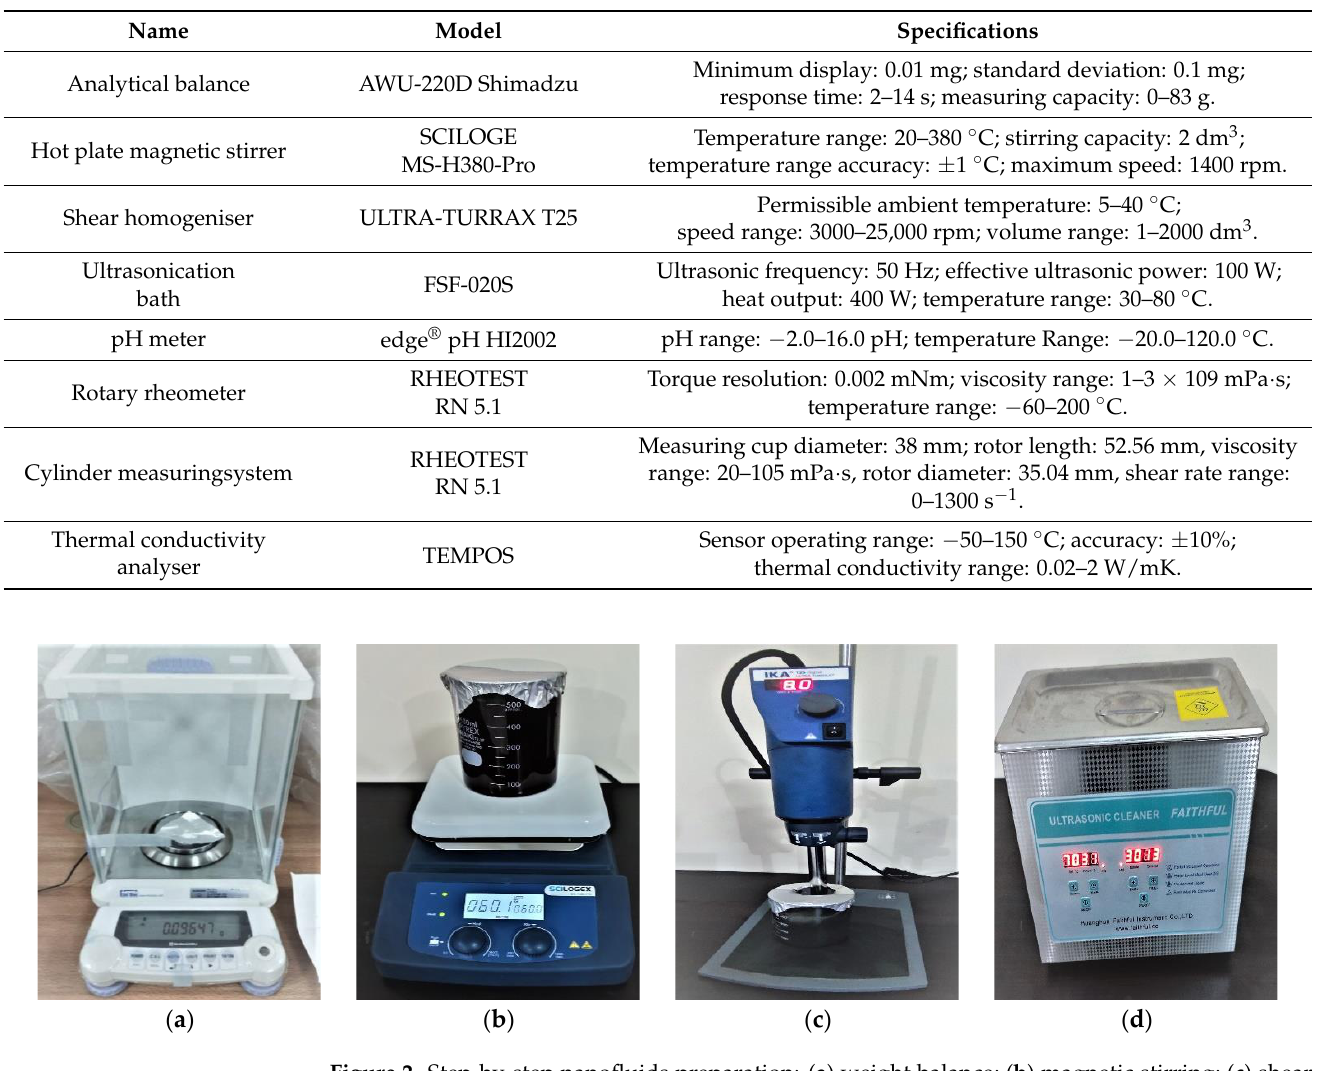
Figure 2. Step-by-step nanofluids preparation: ( a ) weight balance; ( b ) magnetic stirring; ( c ) shear homogenisation; ( d ) ultrasonication. Table 5. Nanofluid sample preparation condition.